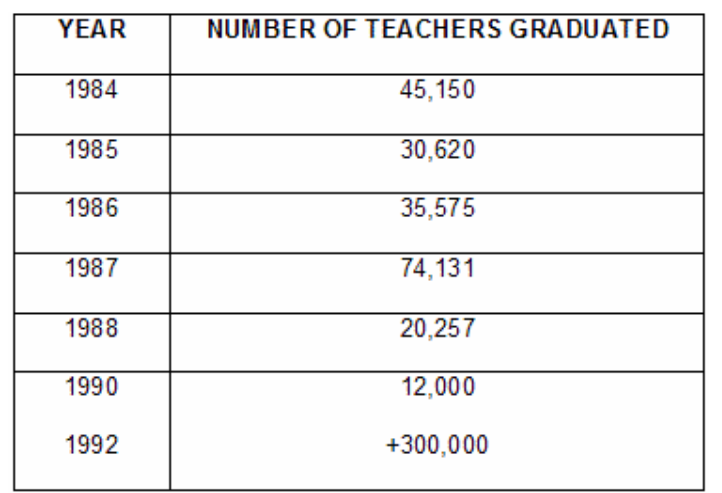
Table 1. NTI Teacher Graduates, 1984 to